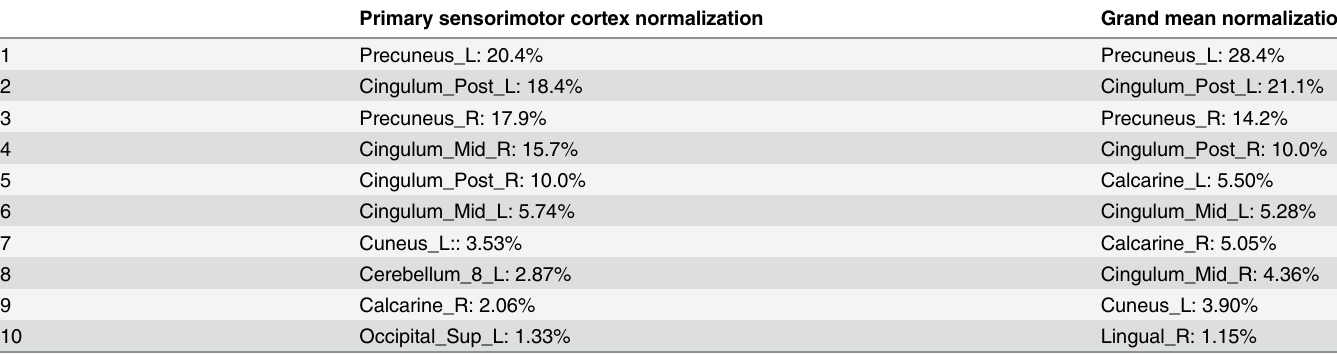
Table 6. Top-10 informative regions (voxels) of MCI against AD using ADNI dataset using BIC. Primary sensorimotor cortex normalization